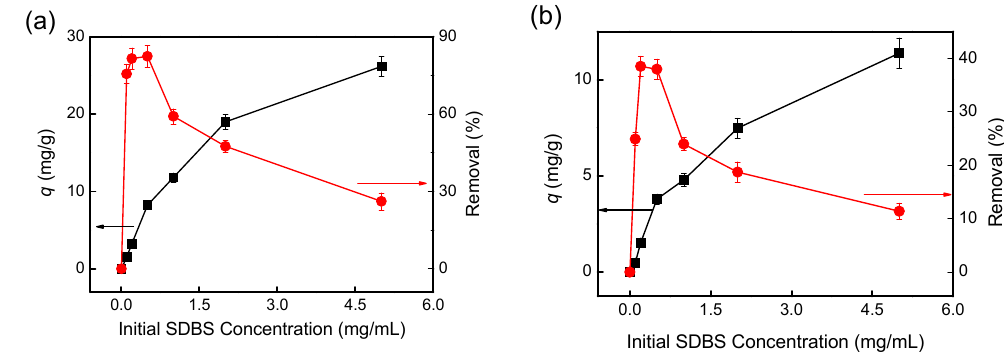
Figure 5. Effect of initial SDBS concentration on the removal of SDBS using ( a ) HP20 and ( b ) HP2MGL. [adsorbents] = 5 mg/mL; adsorption time = 7 h.